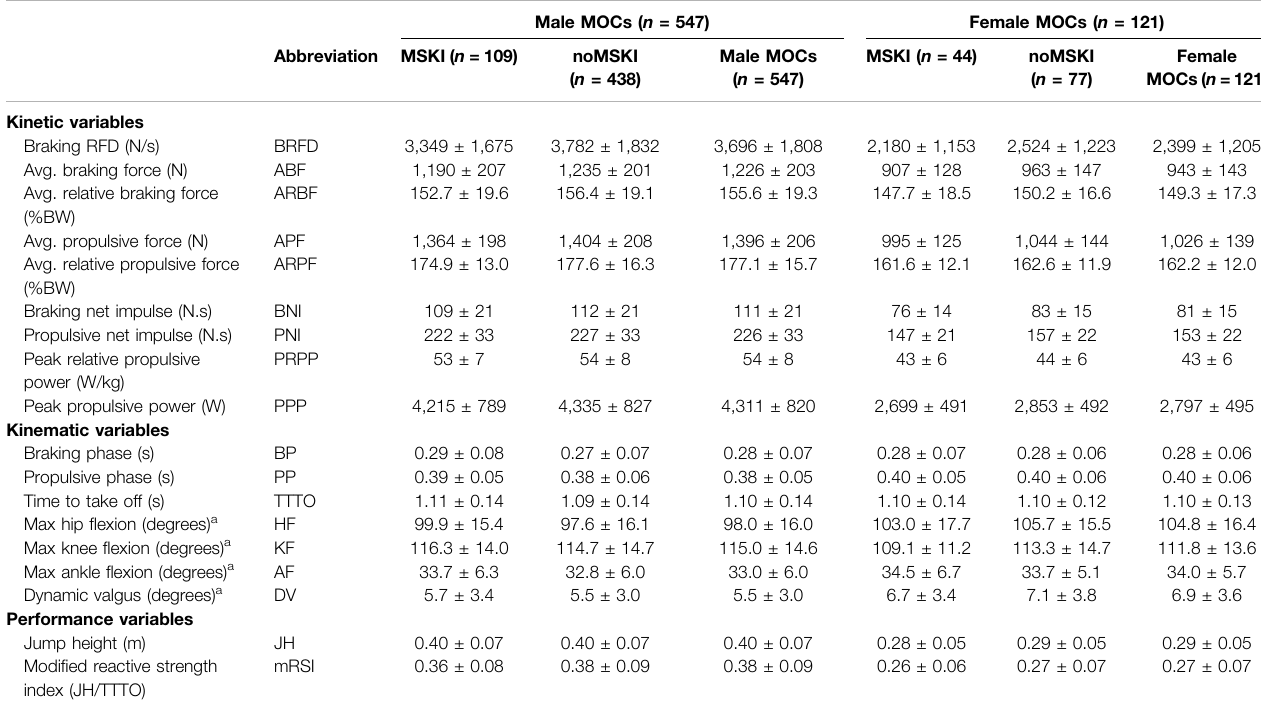
TABLE 2 | Force plate and markerless motion capture variables in Marine Of fi cer Candidates